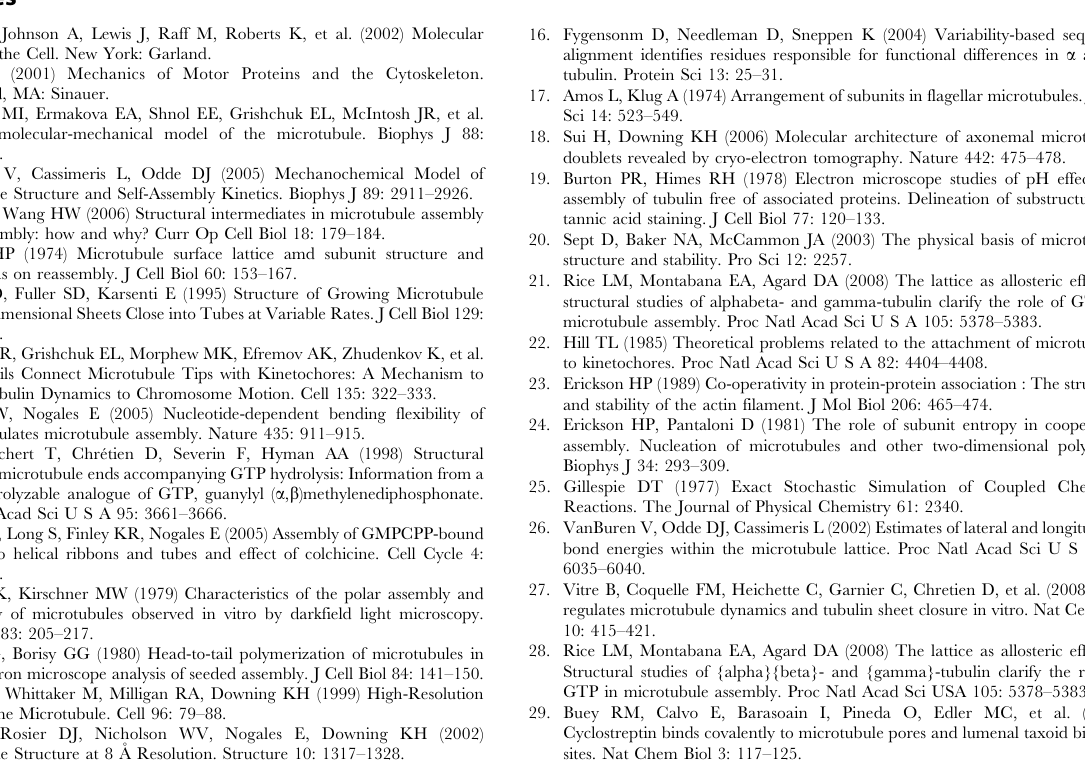
Figure S5 Population ratio of tube-cluster versus sheet-cluster for 2-PF structures as a function of time. Solid and dashed lines with triangles correspond, respectively, to Scheme 1 ( D G ShSh . 0, , 0, D G D G 2 D G D G TuTu Sh Tu = 1.5 k B T, ShSh =6 k B T) and to TuTu = 2 k B T), both at high temperature . The lines without triangles are for Scheme 1 (solid line, D G Sh 2 D G Tu = 2 1.5 k B